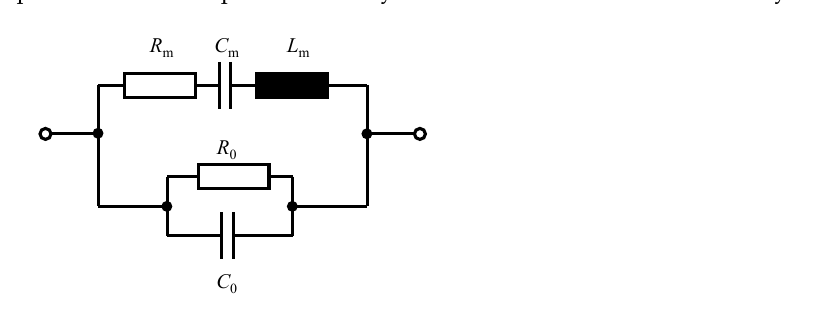
Figure 1. Lumped-element equivalent electrical circuit of a piezoelectric